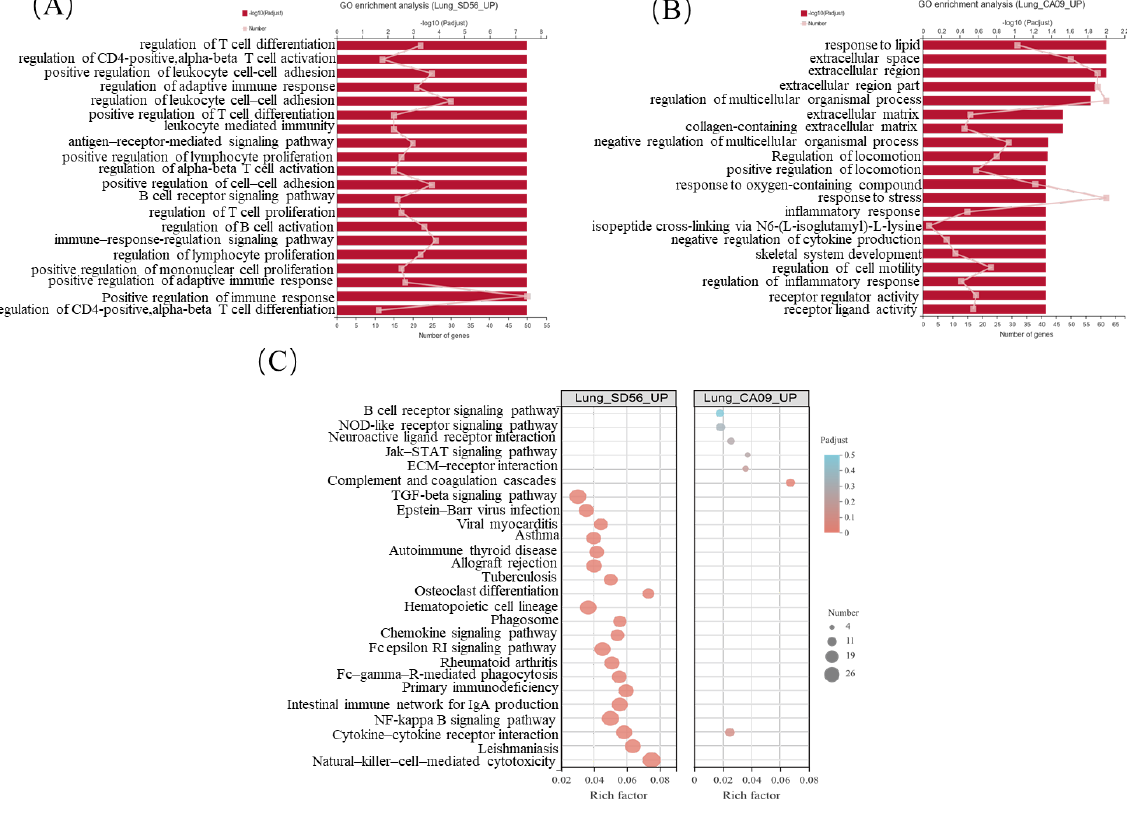
Figure 4. GO and KEGG functional enrichment of upregulated genes in mice lungs. ( A ) GO enrichment analysis of uniquely upregulated lung genes in SD56 relative to the control; ( B ) GO enrichment analysis of uniquely upregulated lung genes in CA09 relative to the control; ( C ) KEGG enrichment bubble diagram of uniquely upregulated lung genes in SD56 relative to the control (left) and in CA09 relative to the control (right). Circles indicate the numbers of genes and colors depict the richness factors.